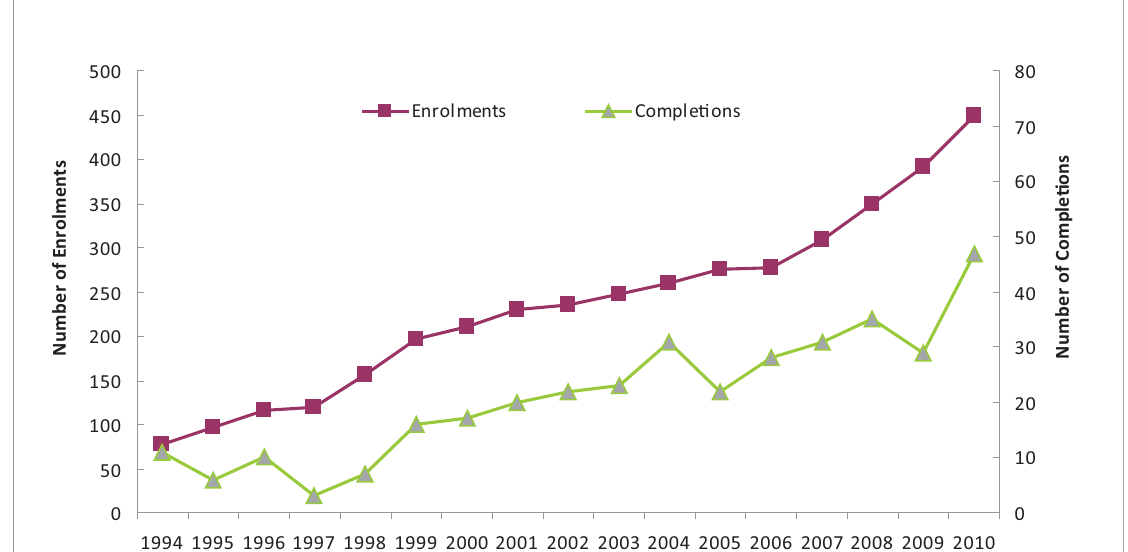
(Colour online) Patterns of enrolment and completion for M¯aori PhDs in New Zealand universities from 1994 to 2010 (from data supplied by the New Zealand Ministry of Education).